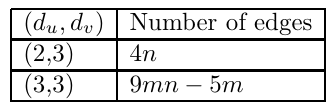
Table 3. The number of three types of edges of the graph T